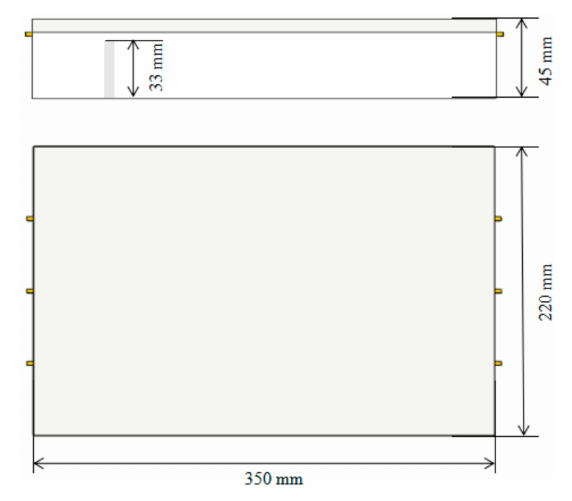
Figure 6. Dimension diagram of imitation thrust bearing bush.